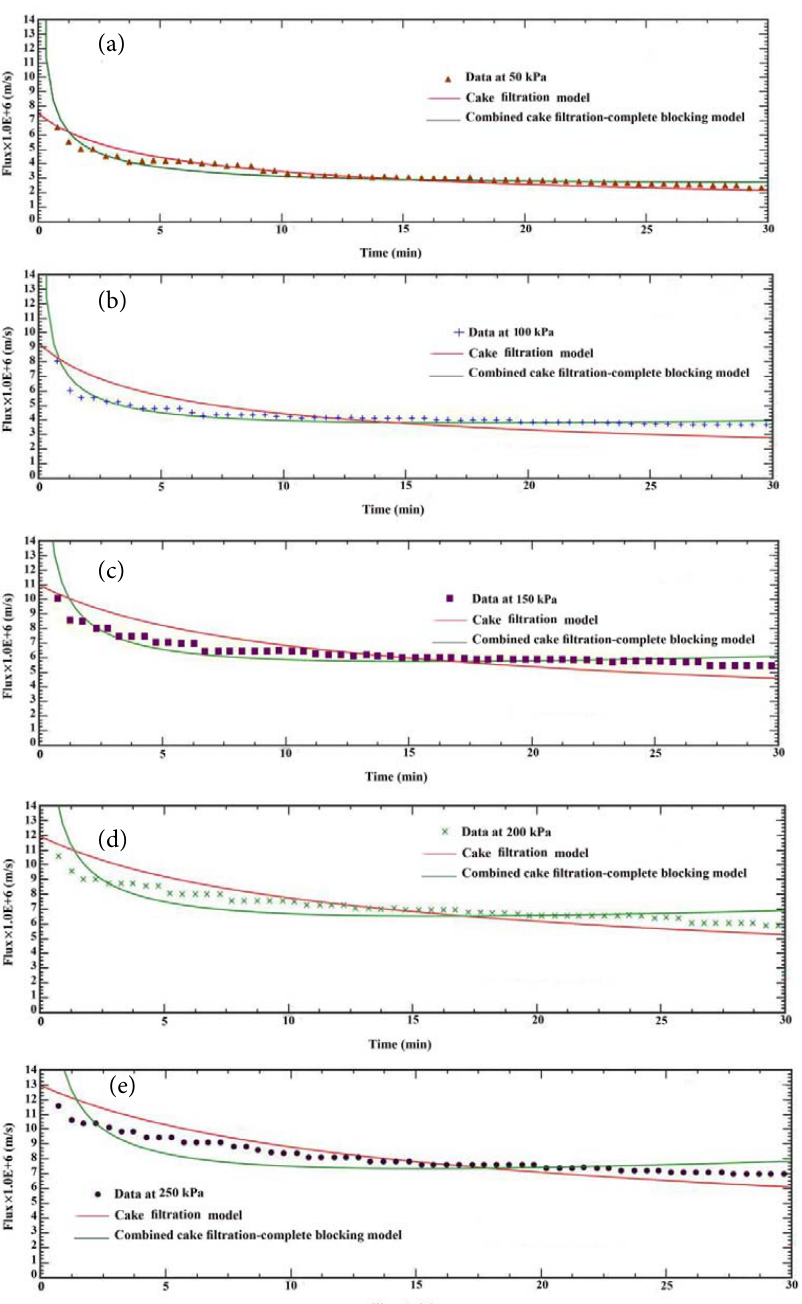
Fig. 1: Flux vs. time data for skim milk through spiral wound ultrafiltration membrane module compared to the cake formation model and combined cake filtration-complete blocking model: (a) 50 kPa, (b) 100 kPa, (c) 150 kPa, (d) 200 kPa and (e) 250